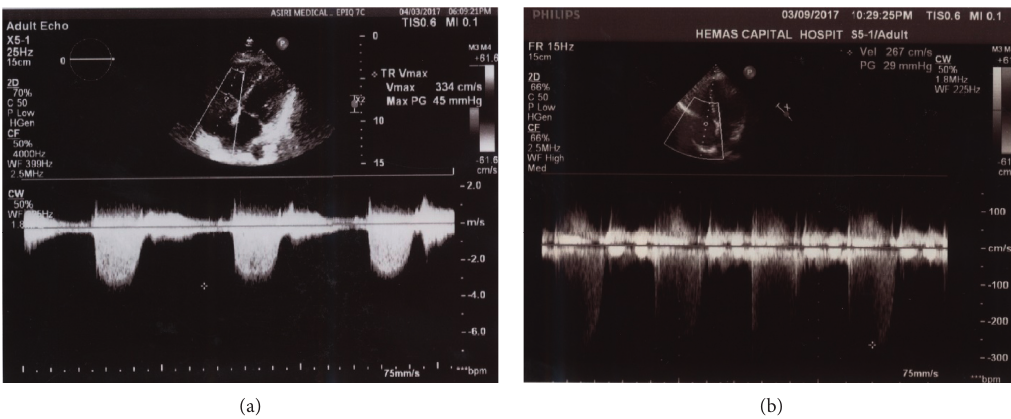
Figure 2: Transthoracic echocardiography demonstrating pulmonary artery pressures before (a) and after (b) the treatment of